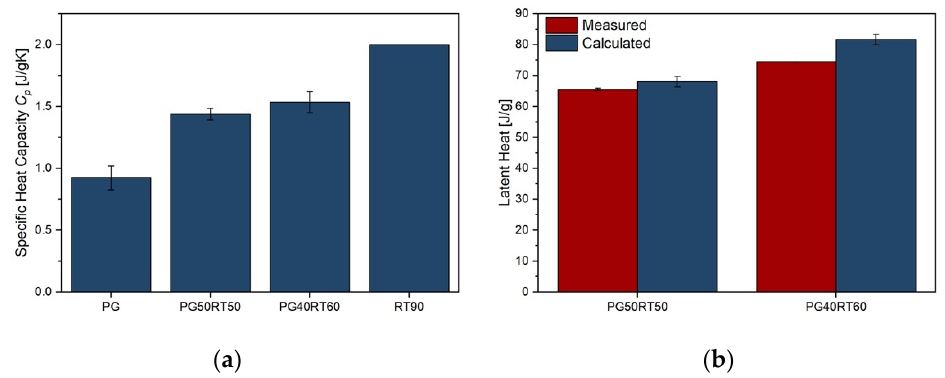
Figure 1. ( a ) Average specific heat capacity of PG, CPCMs and RT90 in the temperature range of 25– 100 °C after 96 cycles. ( b ) Measured and calculated latent heat of